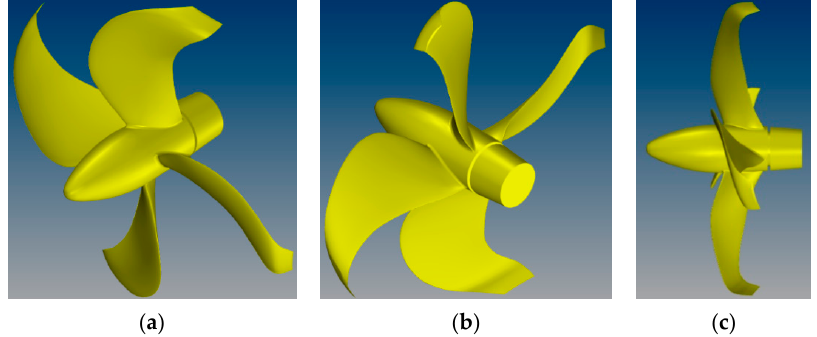
Figure 1. P1727 propeller geometry. ( a ): pressure side view; ( b ): suction side view; ( c ): side view.